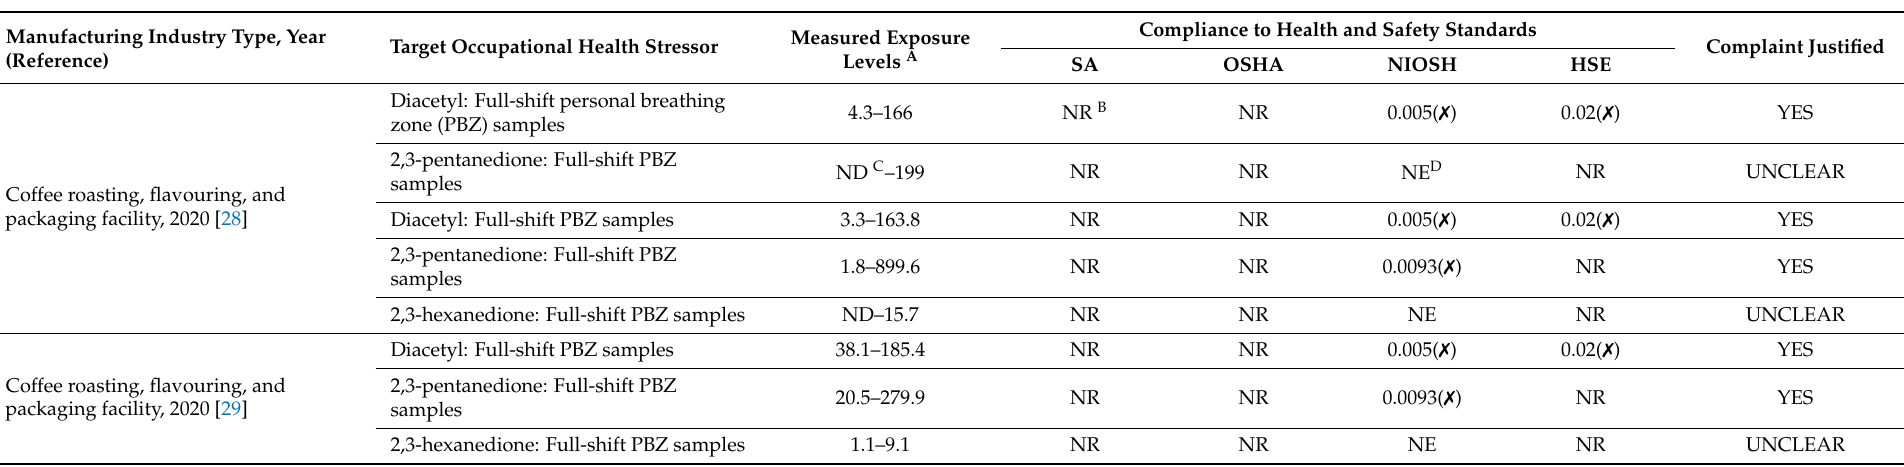
Table 2. Quantitative presentation of the occupational hygiene measurement outcomes used during